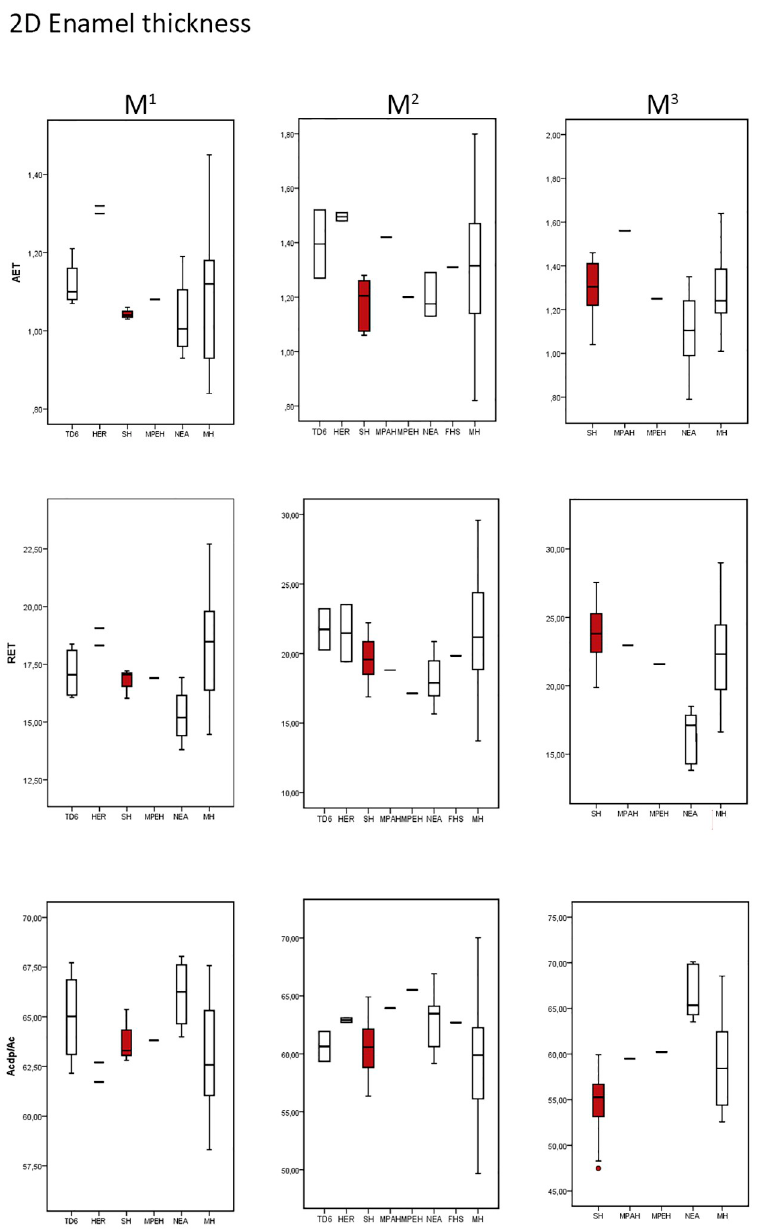
Fig 1. Box plots depicting 2D values. Values of the average enamel thickness (AET), relative enamel thickness (RET) and percentage of dentine and pulp (b/a) in the maxillary molars of the SH and the comparative specimens/samples. upper M1, the fossil H . sapiens from Qafzeh15 value [29] for the upper M2 and the African Middle Pleistocene specimen from Thomas Quarry3 [29] for the upper M3. Still, the maxillary SH sample range overlaps with TD6, Neanderthal, and modern human populations, except for the Neanderthals upper M3 that shows lower values (Fig 1). For the 2D AET and 2D RET, the H . erectus sample, including the upper M1 from China (specimen CA770, [44]) and Sangiran (specimen NG91-G10n˚1, [45]) and the upper M2 from Hexian (specimen PA833, [49]), is outside the range of variation of the SH population (Table 2 and Fig 1).